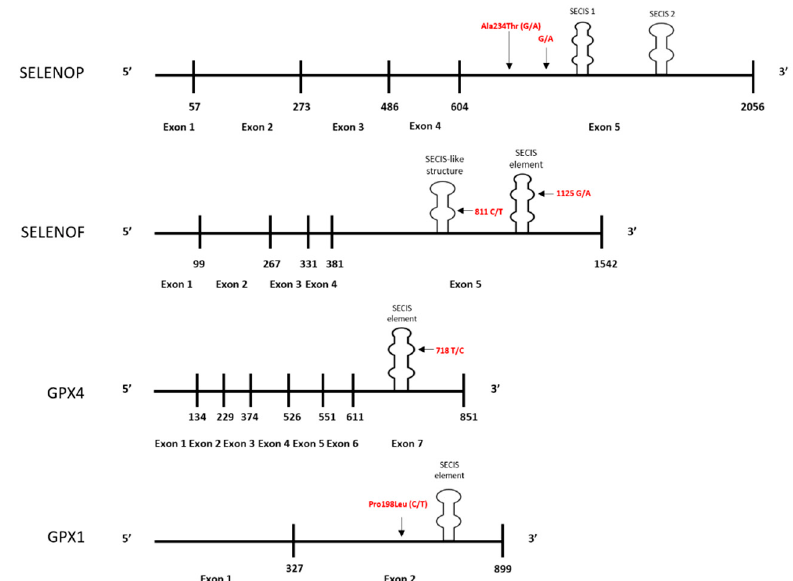
Figure 1. Locations of polymorphisms in selenoprotein genes implicated in cancer and likely impact selenium’s impact on translation. Polymorphism locations for the mRNAs encoded by the SELENOP , SELENOF , GPX4 , and GPX1 genes are shown. Variations in the coding regions and 3 ′ UTR’s of these proteins are indicated in red, and likely impart selenium responsiveness by influencing protein synthesis or selenocysteine incorporation. Vertical lines correspond to exon-exon junctions, which are numbered with the last nucleotide of the preceding exon. Horizontal lines indicate the length of selenoprotein mRNA relative to the other